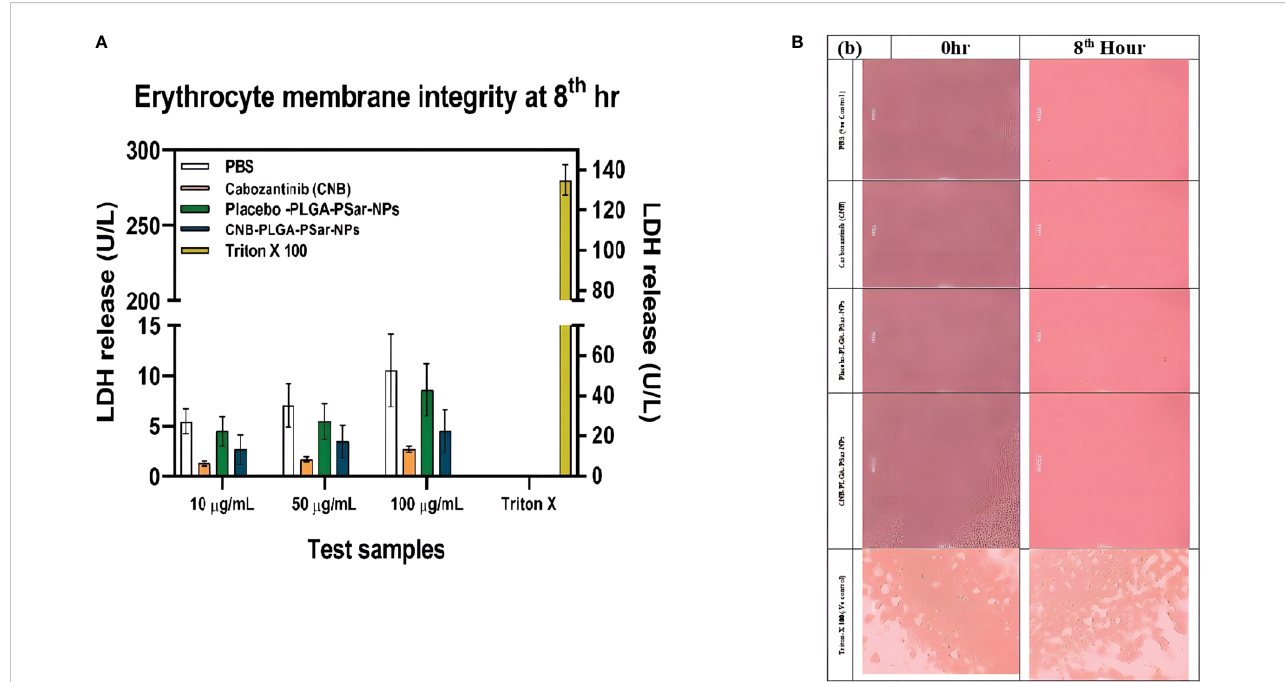
FIGURE 8 (A) . Amount of LDH release after treating with different concentration (10 µg/mL,50 µg/mL,100µg/mL) of Cabozantinib (CNB), PLGA-PSar-encapsulated Cabozantinib nanoparticles (CNB-PLGA-PSar-NPs), and placebo (PLGA-PSar-NPs) nanoparticles against PBS (posative control) Triton X 100(negative control) at 8th hour. (B) . Microsopic images of human erytocytic membrane after incorporation of CNB, PLGA-PSar-NPs, CNB-PLGA-PSar-NPs in the presence of posative and negative control.